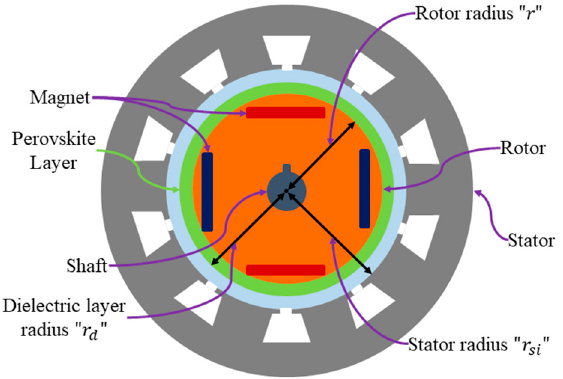
Figure 5. Stator to rotor concentric capacitor with compound dielectric. 𝜺 𝒓𝟐 = 𝜺 𝟎 since the second medium constitutes of air.